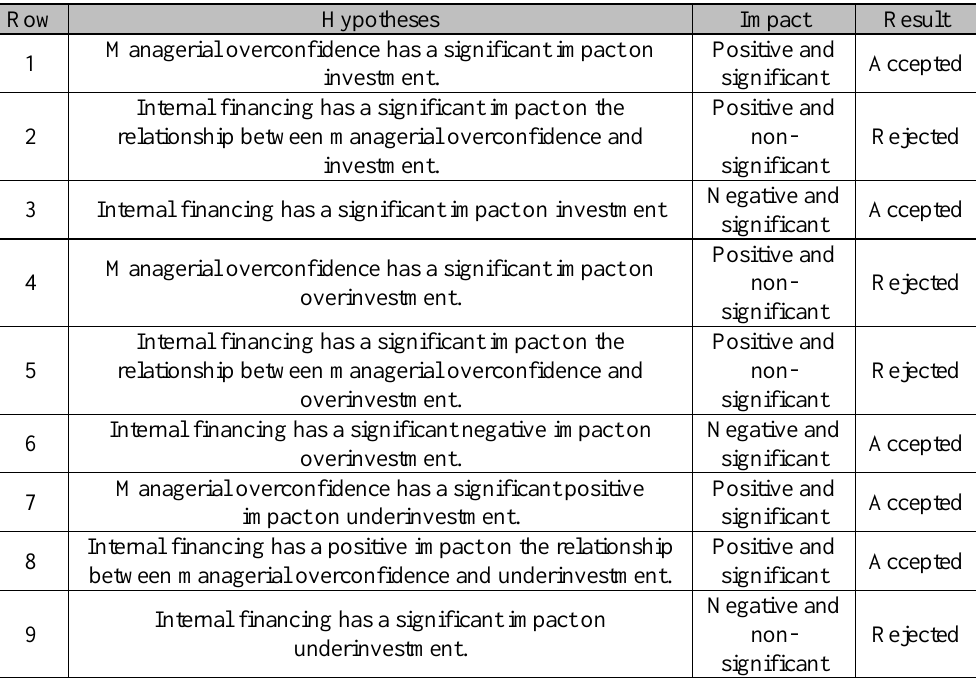
Table 11. Summary of hypotheses